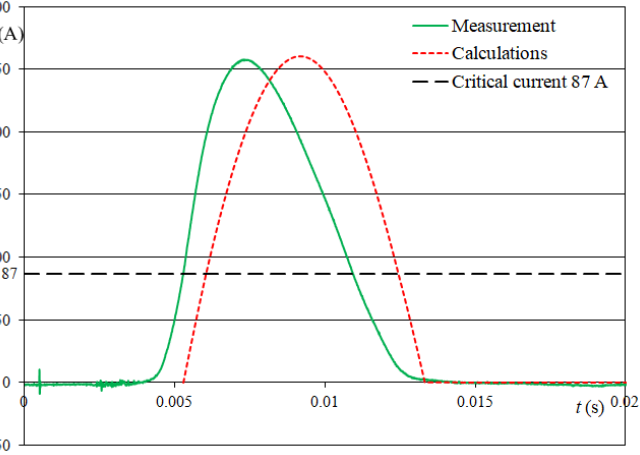
Figure 15. First impulse of inrush current of the 13.8 kVA HTS transformer measured and calculated.